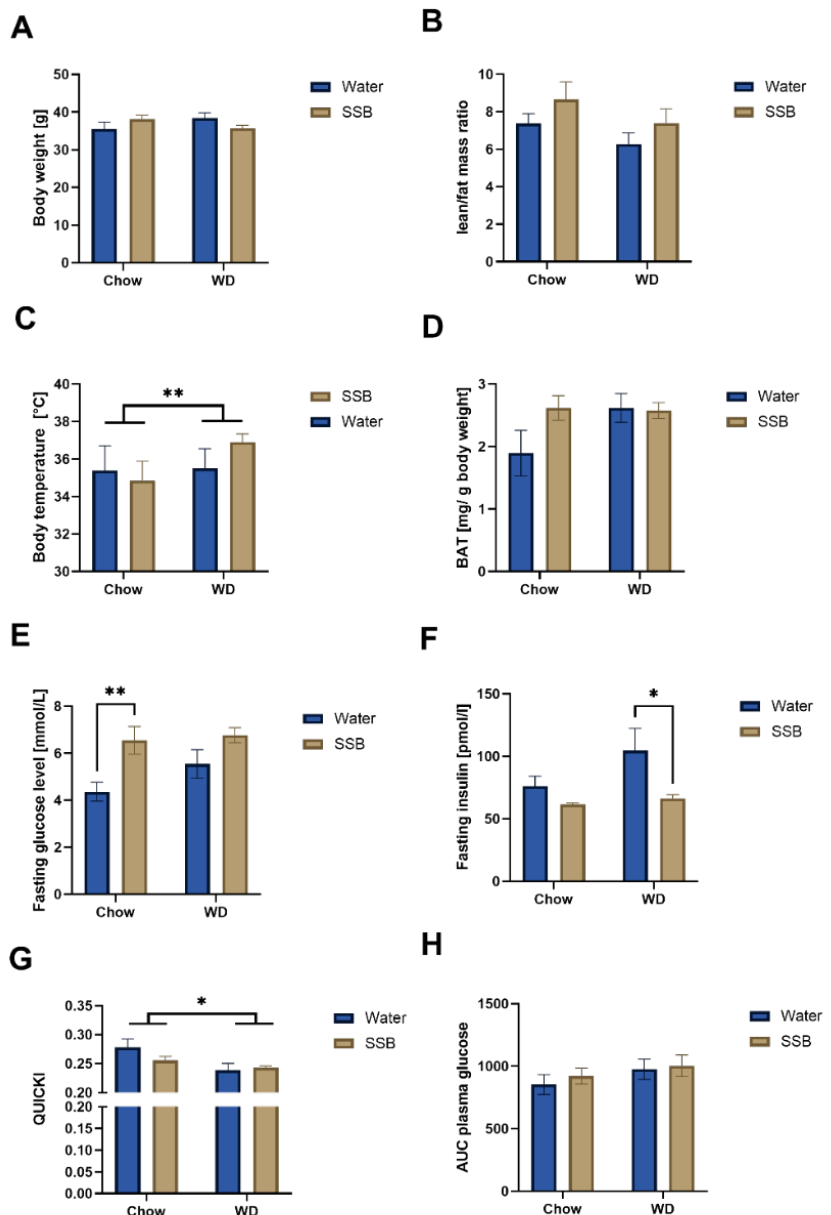
Figure 2. ( A ) Mean body weight ( n = 11–12 for chow group, n = 7–8 for WD group), ( B ) mean lean/fat mass ratio, ( n = 11–12 for chow group, n = 7–8 for WD group), ( C ) total mass of brown adipose tissue (BAT), ( n = 9–12 for chow group, n = 7–8 for WD group), ( D ) mean body temperature ( n = 11–12 for chow group, n = 5–8 for WD group), ( E ) mean fasting glucose level, ( n = 11–12 for chow group, n = 7–8 for WD group), ( F ) mean fasting plasma insulin concentrations ( n = 11–12 for chow group, n = 7–8 for WD group), ( G ) mean values for quantitative insulin sensitivity check index (QUICKI) ( n = 9–11 for chow group, n = 7–8 for WD group), and ( H ) mean area under the curve (AUC) obtained from glucose concentrations during an oral glucose tolerance test ( n = 11–12 for chow group, n = 7–8 for WD group). Data is shown as mean ± SEM, from mice receiving either a standard diet (chow) or Western-type diet (WD) with water (Water, blue bars) or a sugar-sweetened beverage (SSB, brown bars) as a drink for 24 weeks. Statistical significance was tested using two-way ANOVA with the Holm–Sidak post hoc test, except for quantitative insulin sensitivity check index (QUICKI), which was analyzed using the Mann–Whitney U test due to a lack of equal variances. Significance was assumed at p < 0.05. * p < 0.05, ** p <